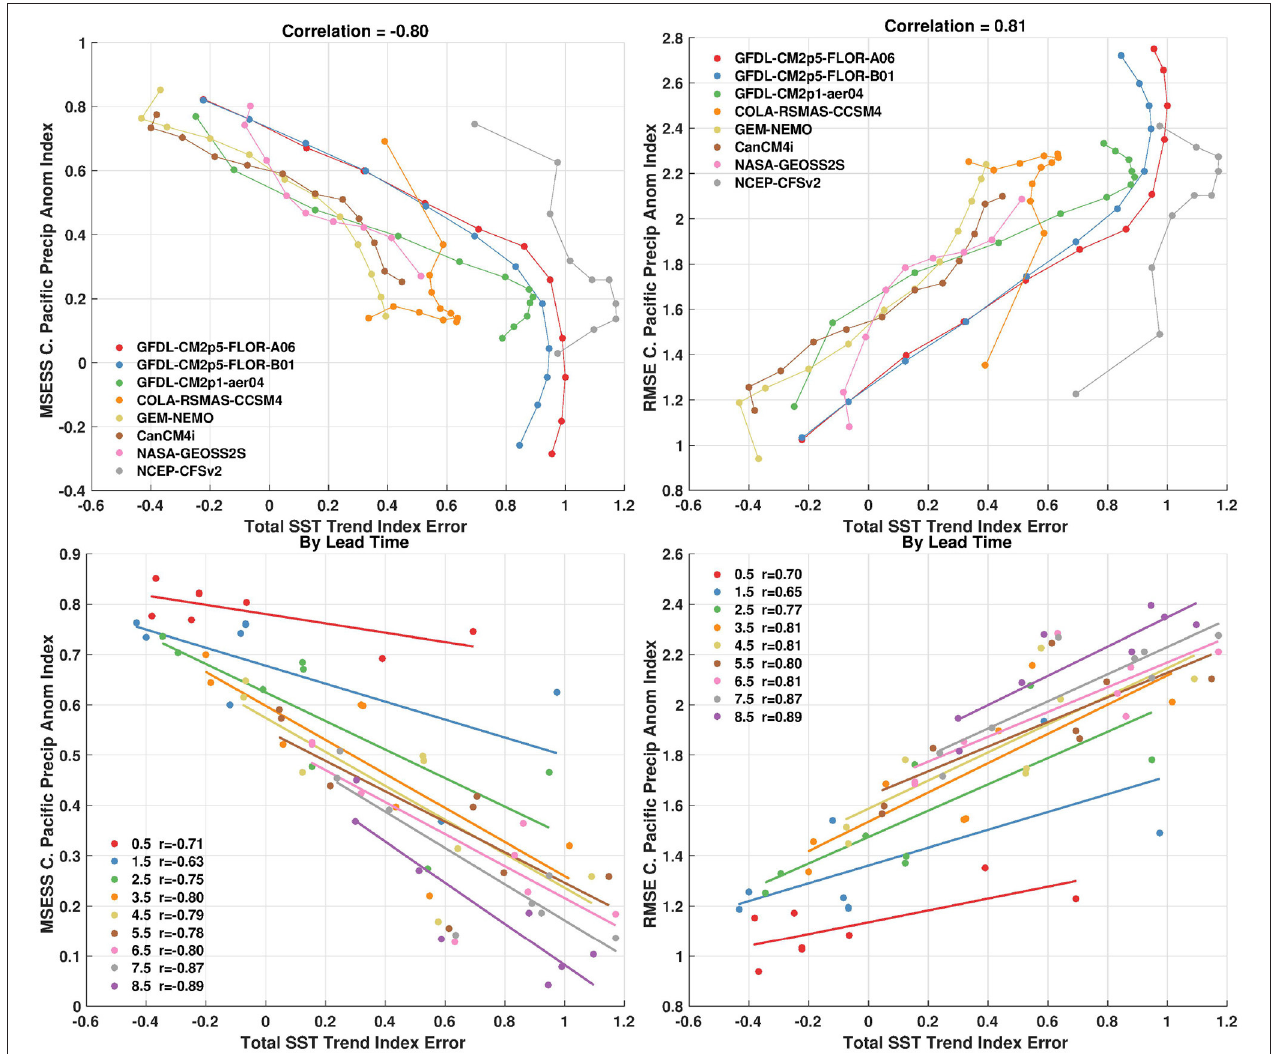
FIGURE 7 | (Top Left) Scatterplot of mean squared error skill score (MSESS) of the central Pacific precipitation anomaly index on the y-axis and the error in the linear trend of the sea surface temperature index on the x-axis. (Top Right) Same as the left panel except showing the root mean squared error (RMSE) of the central Pacific precipitation anomaly index on the y-axis. (Bottom) Same as the top panels except also showing the least-squares fit for each forecast lead time. All forecast leads and NMME models are shown. The lines connect the forecast lead times, with smaller errors generally associated with shorter lead times. MSESS is unitless and is positive for forecasts whose MSE is less than the observed variance. RMSE is in units of millimeters/day. The SST trend index error is in units of degrees Celsius change over January 1982 to December